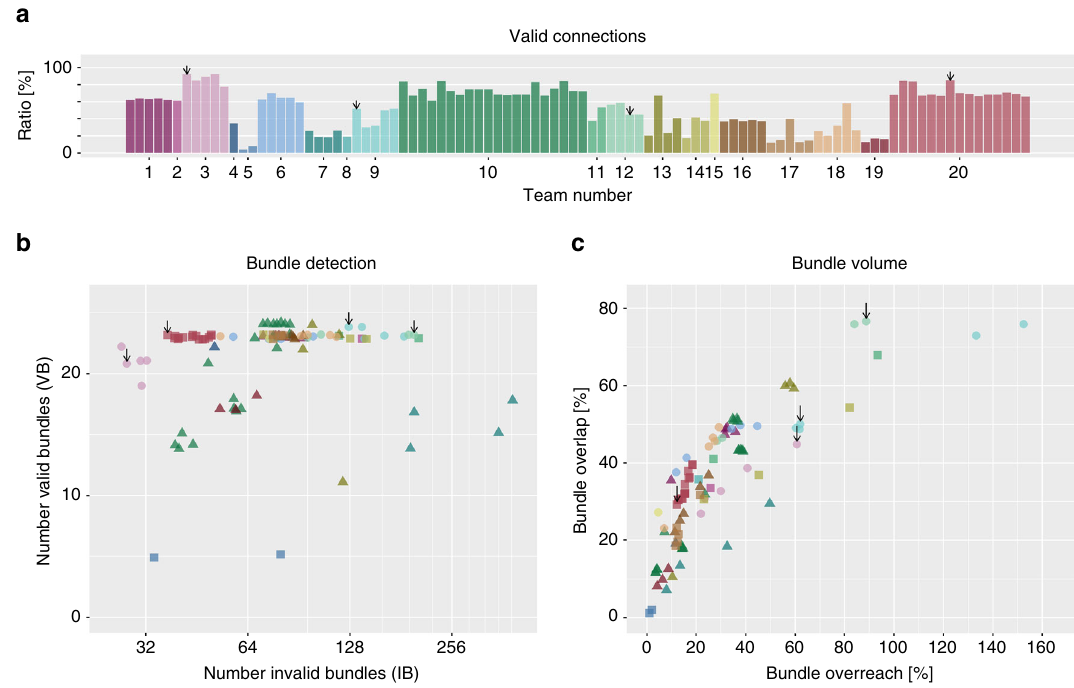
Fig. 4 Between-group differences in tractography reconstructions of VBs and IBs. Overview of the scores reached by the different teams as a percentage of streamlines connecting valid regions, b number of detected VBs and IBs (data points are jittered to improve legibility), and c volume overlap (OL) and overreach (OR) scores averaged over bundles. Black arrows mark submissions used in the following fi gures (see Supplementary Note 5 for